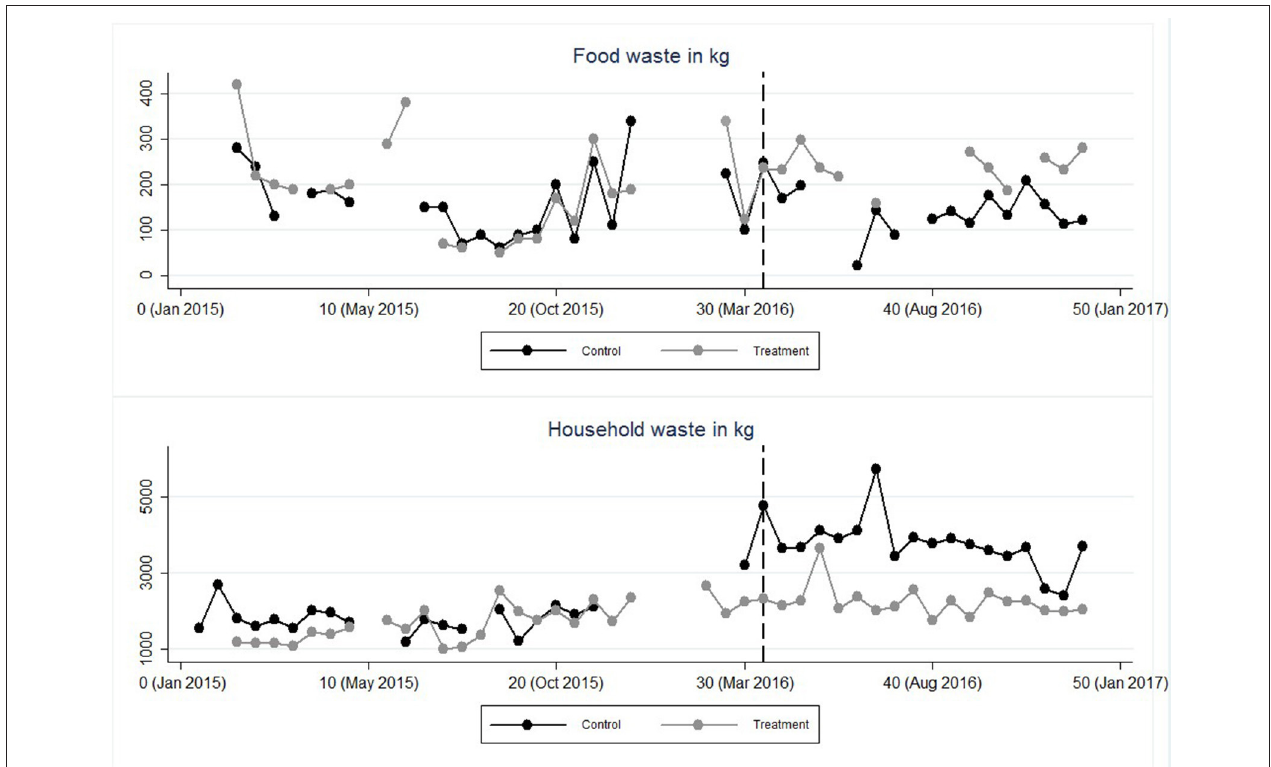
FIGURE 3 | Data points indicate aggregated data on food and household waste registered for all stations in the treatment and control group respectively. Each point represents waste collected over the 2-week period described above starting from February 2015 to December 2016. Note that some of the variation is due to different number of collections in each period. Data points with more than one missing value is removed from the plotted data (but included in the regression analysis).